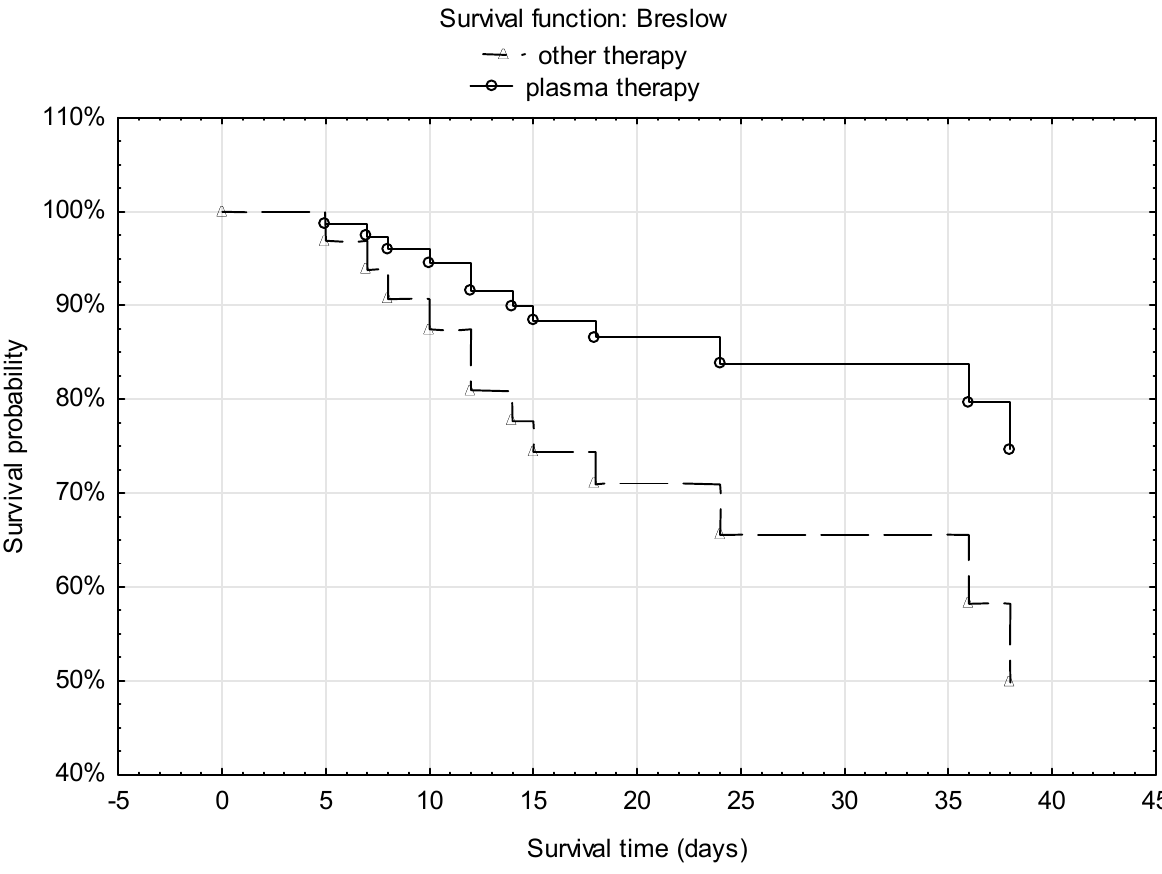
Figure 1. Kaplan–Meier analysis of hematological patients with COVID-19 who received convalescent plasma compared with patients from a historical group treated with other therapy (remdesivir, tocilizumab, hydroxychloroquine, lopinavir/ritonavir). Hazard ratio (HR) and 95% CI are calculated from a Cox model without covariates.